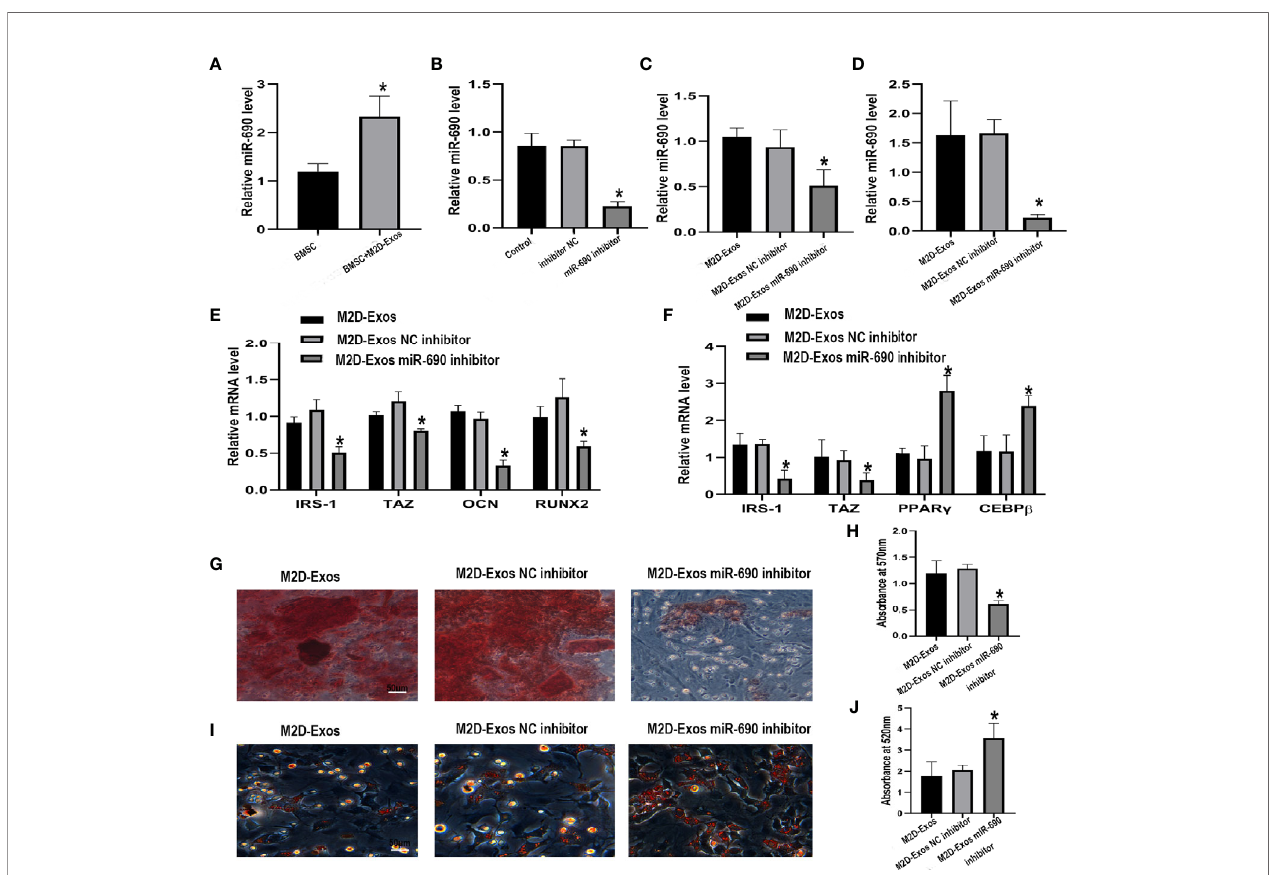
FIGURE 5 | The inhibitor of miR-690 partially reversed the up-regulation osteogenesis and down-regulation adipogenesis induced by M2D-Exos. (A) The level of miR-690 in BMSCs after treated with M2D-Exos or PBS. *p < 0.05 compared to the BMSC group. (B) The level of miR-690 in M2 macrophages after treated with lipo3000, miR-690 inhibitor, or inhibitor control measured by qRT-PCR analysis. Control group was M2 macrophages treated with lipo3000. *p < 0.05 compared to the inhibitor control group. (C) The level of miR-690 in BMSCs after treated with M2D-Exos, miR-690 inhibited M2D-Exos, or inhibitor control M2D-Exos before cultured in osteogenic inducer were measured by qRT-PCR analysis. *p < 0.05 compared to the M2D-Exos NC inhibitor group. (D) The level of miR-690 in M2 macrophages after treated with lipo3000, miR-690 inhibitor, or inhibitor control before cultured in adipogenic inducer were measured by RT-PCR analysis. *p < 0.05 compared to the M2D-Exos NC inhibitor group. (E) IRS-1, TAZ, OCN, RUNX2 mRNA level of BMSCs after treated with M2D-Exos, miR-690 inhibited M2D-Exos, or inhibitor control M2D-Exos during osteogenesis were measured by qRT-PCR analysis. *p < 0.05 compared to the M2D-Exos NC inhibitor group. (F) IRS-1, TAZ, C/EBP b , and PPAR g mRNA level of BMSCs after treated with M2D-Exos, miR-690 inhibited M2D-Exos, or inhibitor control M2D-Exos during adipogenesis were measured by qRT-PCR analysis. *p < 0.05 compared to the M2D-Exos NC inhibitor group. (G) A-R staining was used to measure the formation of bone nodules in BMSCs following treated by M2D-Exos, miR-690 inhibited M2D-Exos, or inhibitor control M2D-Exos for 14 days. Scale bar = 50 µm, (H) The statistical data of Alizarin red-mediated calcium staining. (I) Oil red O staining was used to measure the formation of lipid droplets in BMSCs following treated by M2D-Exos, miR-690 inhibited M2D-Exos, or inhibitor control M2D-Exos for 14 days. Scale bar = 50µm. (J) The statistical data of Oil red O staining. *p < 0.05 compared to the M2D-Exos NC inhibitor